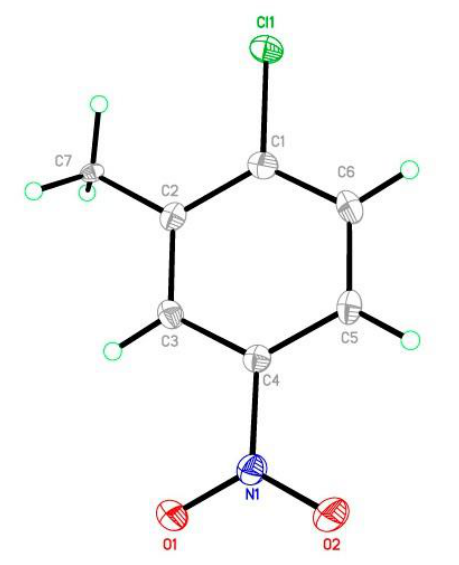
Figure 2. The structure of 3 showing the atom numbering, with displacement ellipsoids drawn at the 50% probability level [16]. For clarity in all of the figures, the H atoms of only one component of the disordered methyl group are shown.